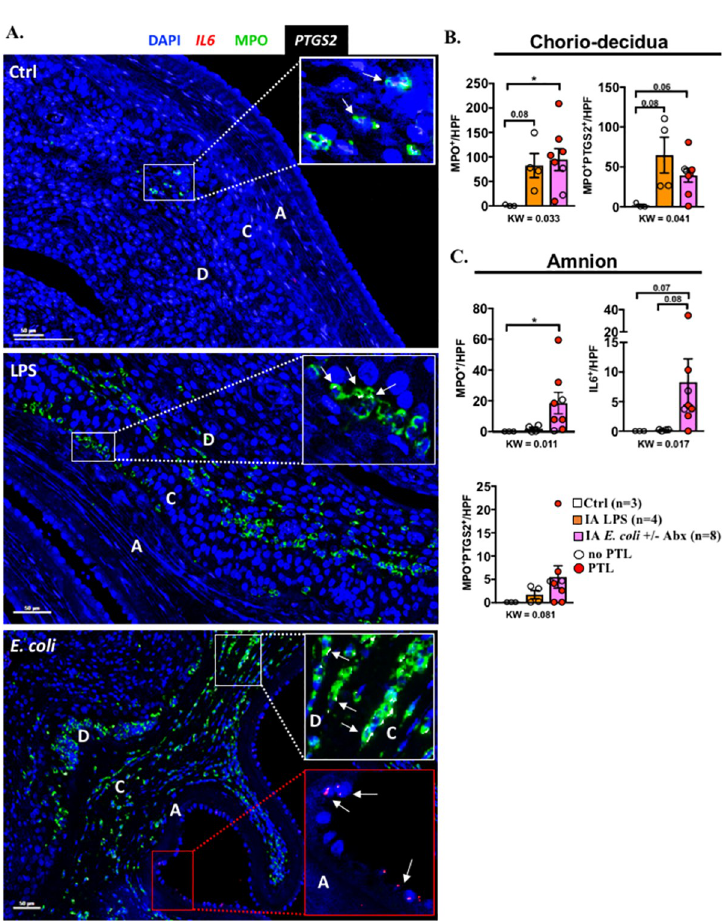
Fig 5. Cellular localization of IL6 and PTGS2 in the fetal membranes. (A) Representative multiplex fluorescence detection of IL6 and PTGS2 mRNA identified by RNAscope in situ hybridization and MPO colocalization by immunofluorescence. IL6 is shown in red, PTGS2 in white, and MPO in green. DAPI indicates nuclear staining (blue) in all images. A = amnion, C = chorion, and D = decidua. White arrows in the white insets indicate colocalization of MPO (green) and PTGS2 (white) in the chorio-decidua. White arrows in the red inset indicate IL6 + epithelial and mesenchymal cells (red) in the amnion. Quantification of the cells expressing different markers in the (B) chorio- decidua and (C) amnion. Average of 5 randomly selected HPF fields were plotted as the representative value for the animal. Counts were performed in a blinded manner. Red circles denote animals with PTL, while clear circles denote animals without PTL. Data are mean, SEM. A p -value for 3 group comparison by KW nonparametric test is shown in each panel, with post hoc analysis by DSCF method showing � p < 0.05 or a borderline p -value between comparators. See S1 Data for numerical values. Abx, antibiotics; DSCF, Dwass–Steel–Critchlow–Fligner; HPF, high-power field; IA, intra-amniotic; LPS, lipopolysaccharide; KW, Kruskal–Wallis; MPO, myeloperoxidase; PTL, preterm